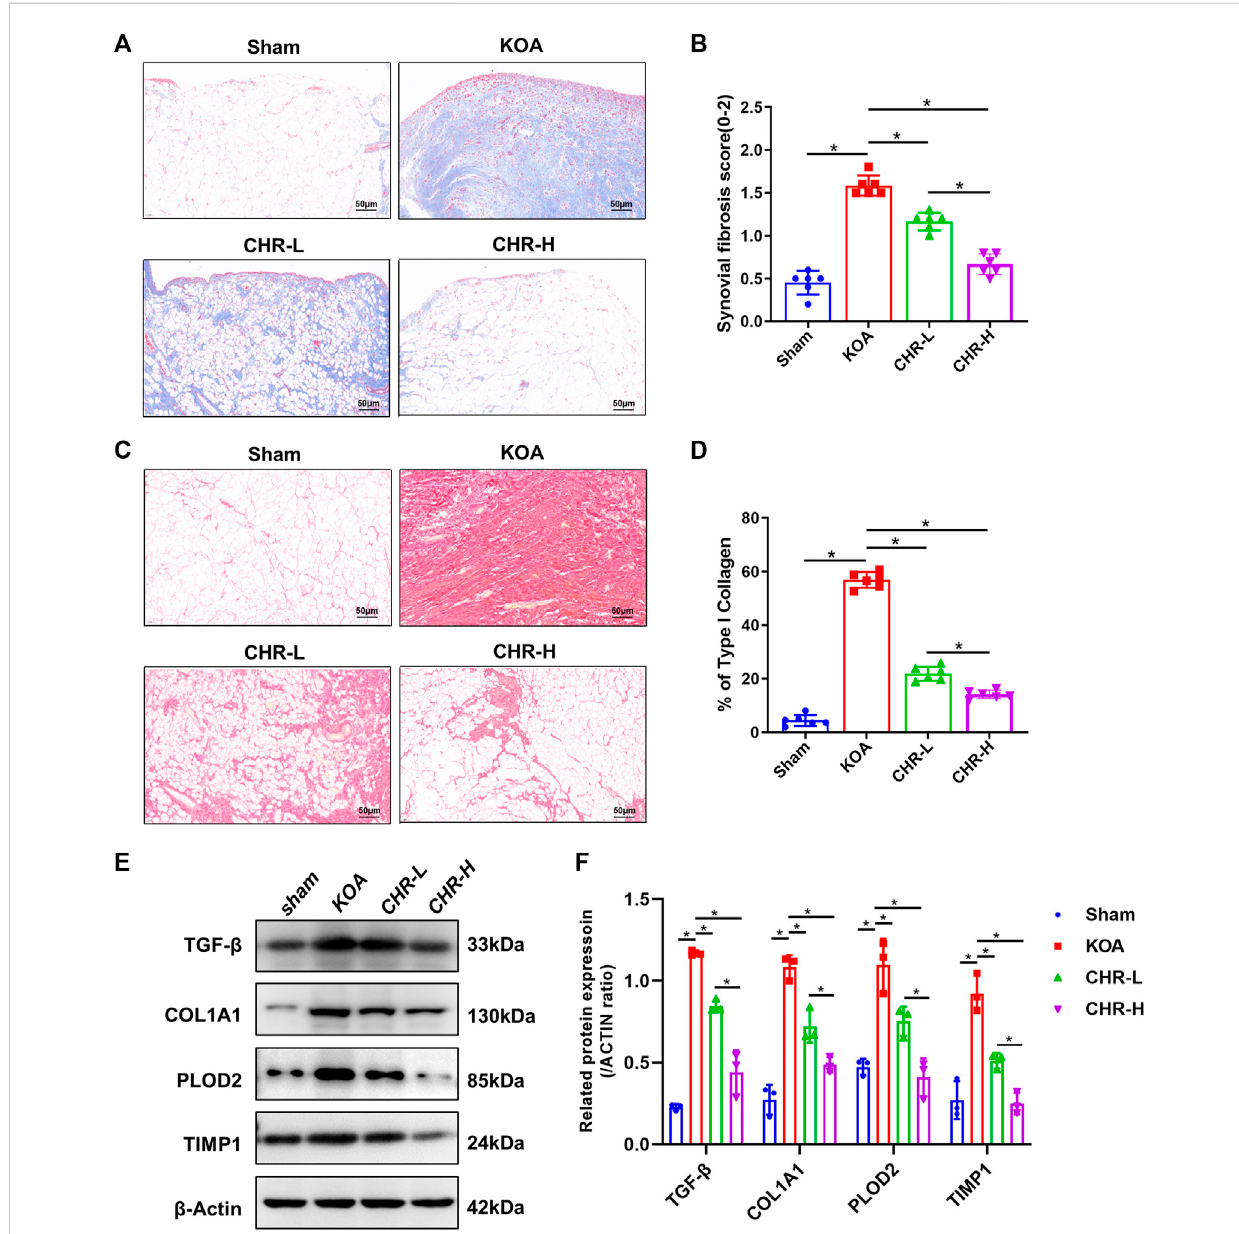
CHRalleviatessynovial fi brosisinKOArats. (A) RepresentativeimagesofsynovialsectionsstainedwithMassonandexaminedat×200magni fi cation. n = 6. Scale bars: 50 μ m. (B) Quantitative analysis of the synovial fi brosis score. (C) Representative images of synovial sections stained with Sirius red and examined at ×200 magni fi cation. n = 6. Scale bars: 50 μ m. (D) Quantitative analysis of type I collagen (% area) in each group. (E) Immunoblot analysis of TGF- β ,COL1A1,PLOD2, andTIMP1. (F) Protein levels ofTGF- β , COL1A1, PLOD2, andTIMP1inthegroups.n= 3pergroup. The data inthis fi gureare presented as the mean ± standard deviation, and statistical signi fi cance was determined with one-way ANOVA followed by Tukey ’ s post hoc analysis. p p <